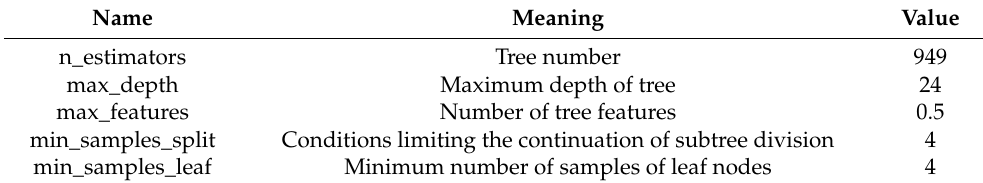
Table 2. Optimal hyperparameters of the random forest model.